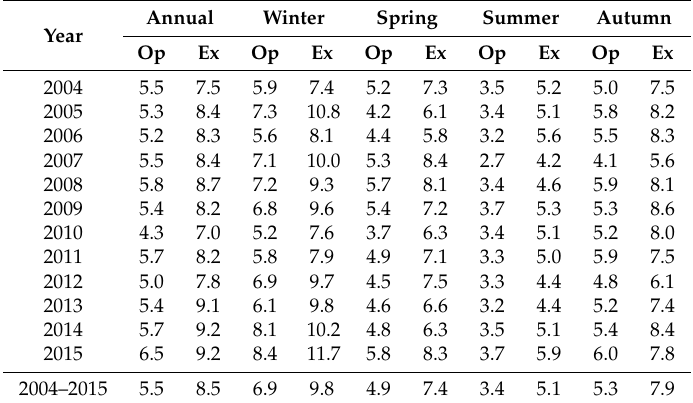
Table A3. Annual and seasonal operational (Op) and extreme (Ext) H s thresholds (m) at BA.